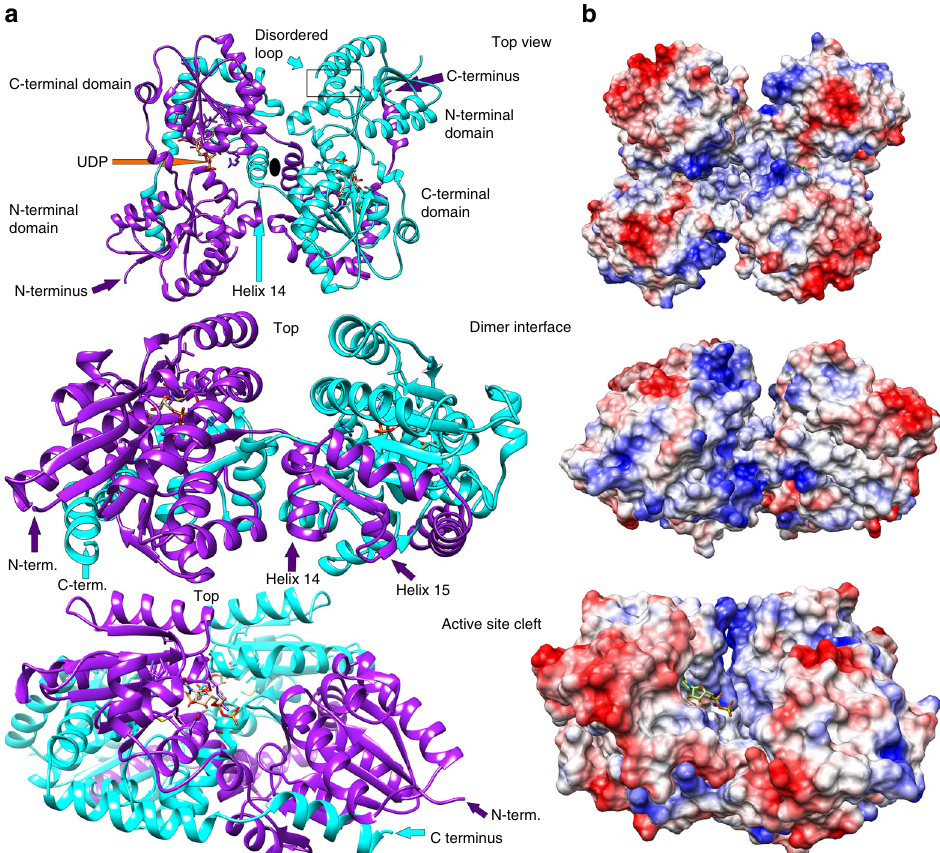
Fig. 2 Overall structure of LpxB. a The overall structure of LpxB7S shows that LpxB forms a dimer in which the C-terminus of one subunit completes the fold of the opposite subunit. The polypeptides are exchanged at helix 14. Each domain forms a Rossmann-like fold with a parallel β -sheet surrounded by α - helices. UDP is bound to the C-terminal domain showing the position of the UDP-binding pocket where the sugar donor substrate, UDP-DAG, binds. Lipid X likely binds to the N-terminal domain which includes the predicted catalytic base D98 10 . LpxB appears to be in an open conformation. Catalysis may involve partial closing of the cleft between the domains by a hinge-like movement of the N-terminal domain similar to conformational changes observed for MurG 38 , PimA 50 , and other GT-B enzymes 40 . b Columbic surface rendering (blue for positive and red for negative) corresponding to the adjacent ribbons in a . The surface near the dimer interface is highly basic and is likely involved in membrane